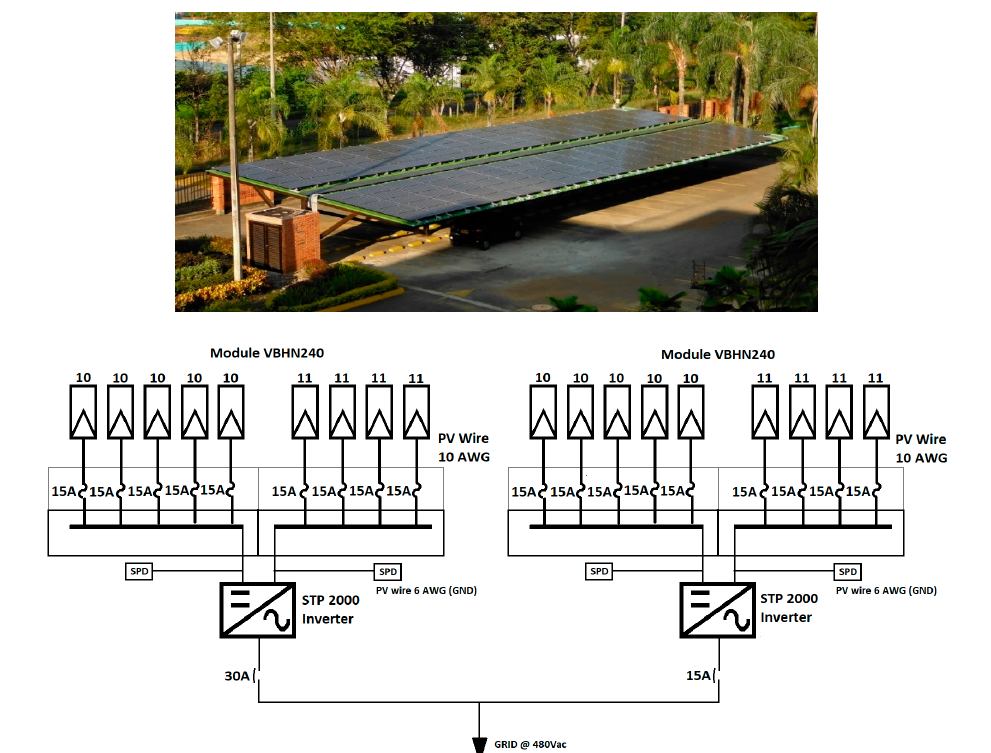
Figure 2. Parking located in the North. Stage 1.